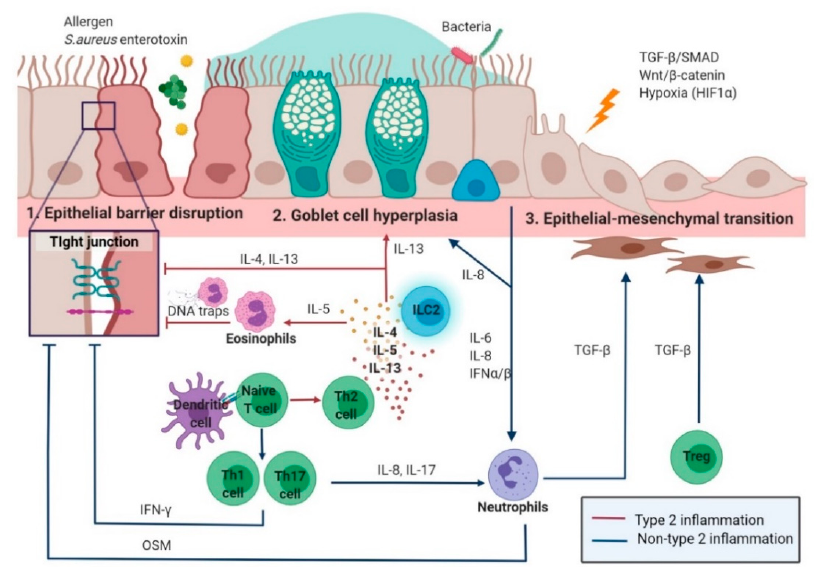
Figure 1. Pathophysiology of epithelial remodeling (epithelial barrier disruption, goblet cell hyper- plasia, and epithelial–mesenchymal transition) in chronic rhinosinusitis according to the type of inflammation (type 2 versus non-type 2) (figure created using